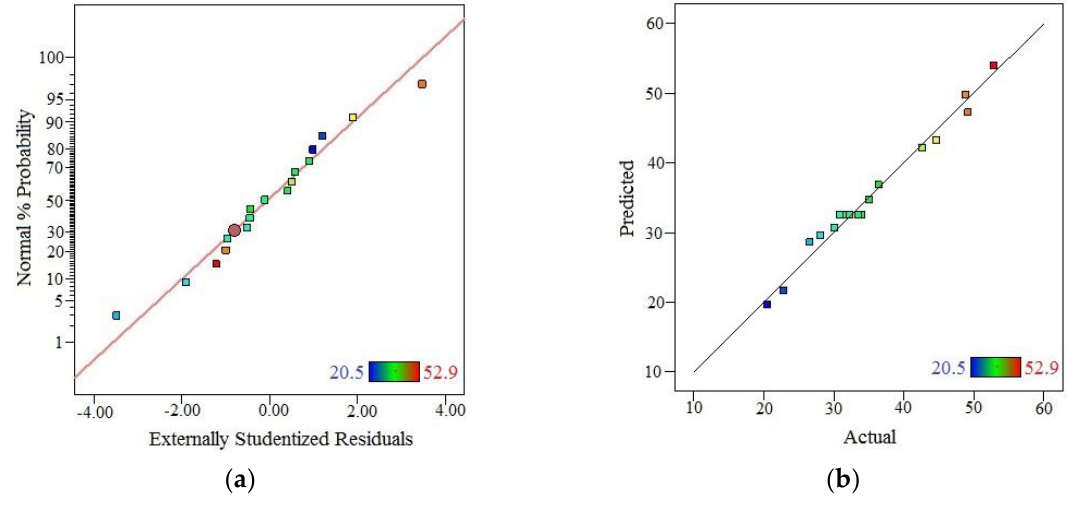
Figure 5. ( a ) Normal % probability plot of residuals for coverage percentage; ( b ) plot of actual vs. predicted response for coverage percentage.